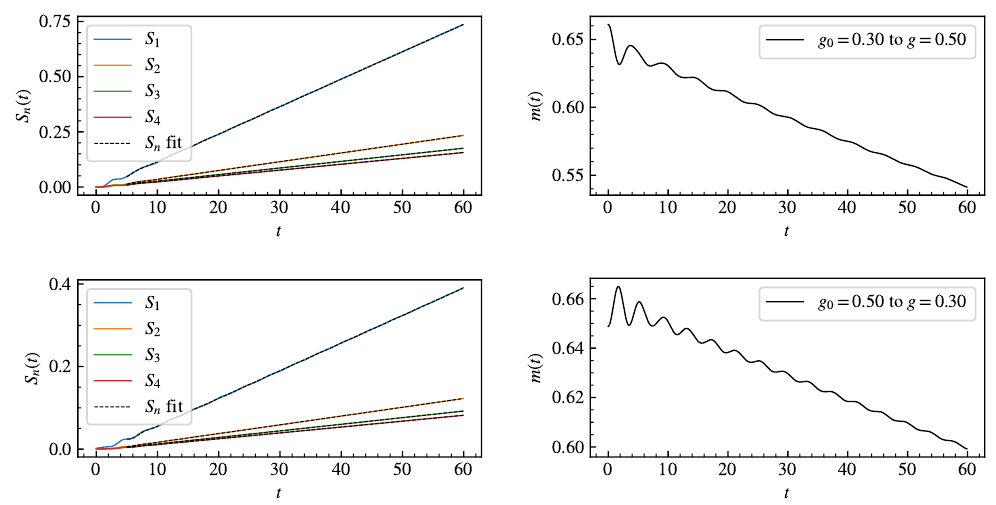
Figure 3.1: Rényi entropies and magnetisation time evolution for the quenches = 0.3 → g = 0.5 (a) and g = 0.5 → g = 0.3 (b). Time is measured in units g 0 0 of 1 / J , and the initial entropy was